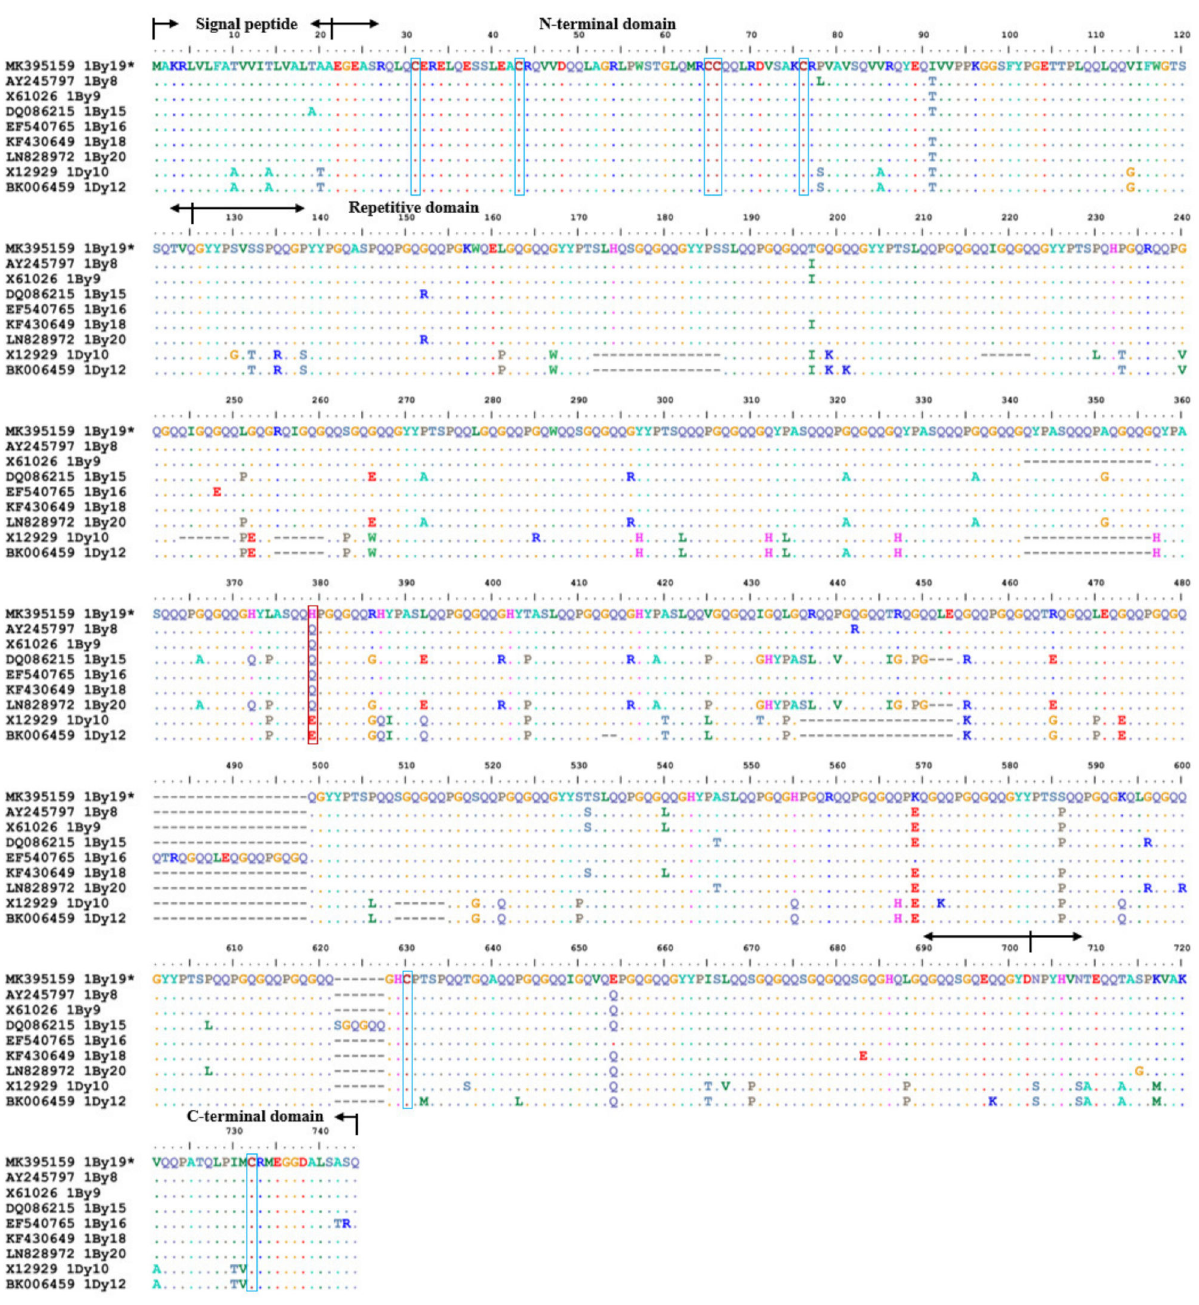
Figure 3. Comparison of the deduced amino acid sequences of 1By19* gene from spelt wheat with other eight y-type subunit genes. The blue boxes indicate the cysteine residues, red boxes indicate differences of amino acid. Table 1. Positions of SNPs identified between 1Ax2.1* and other x-type HMW-GS